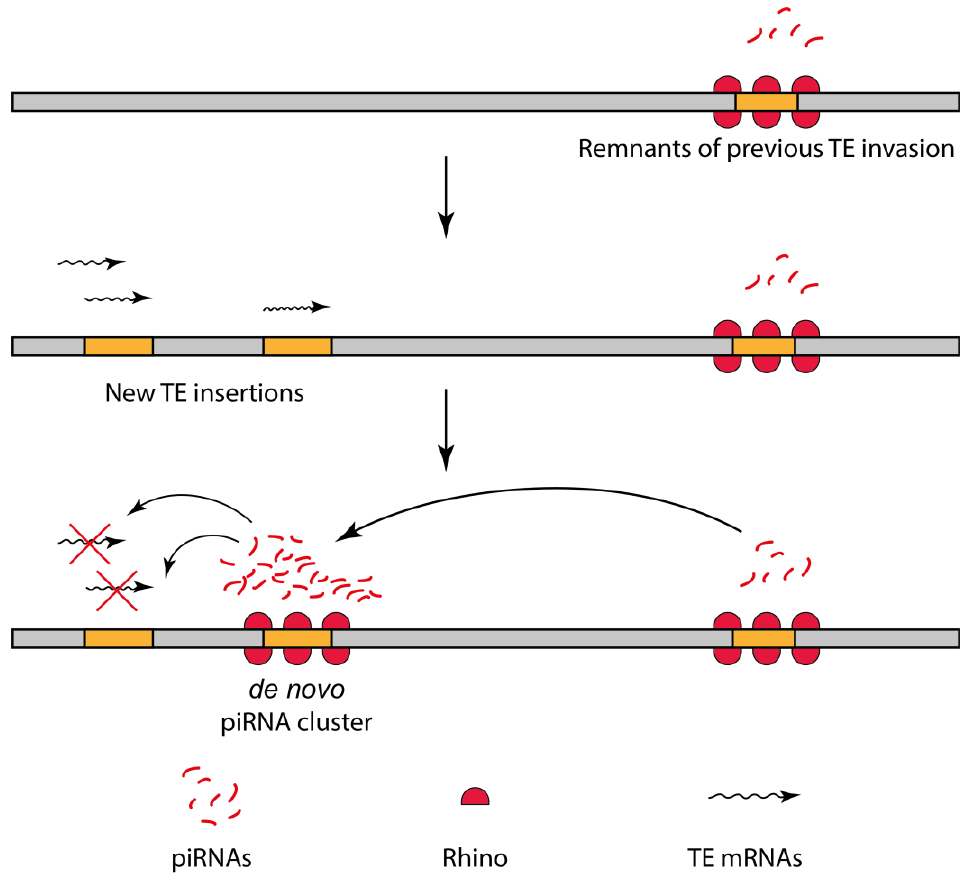
Figure 8. A model of de novo piRNA cluster formation. A low amount of endogenous piRNAs can cause de novo formation of a robust piRNA cluster at the cognate sequences, thus boosting the RNAi response against genome invaders.